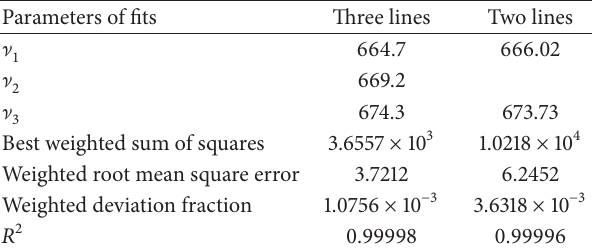
Table 1: Computation results obtained with (three lines) and without (two lines) distinguishing between monomeric and dimeric molecules of the solvent in the DMSO solution containing 0.15 mole fractions of LiClO 4 .